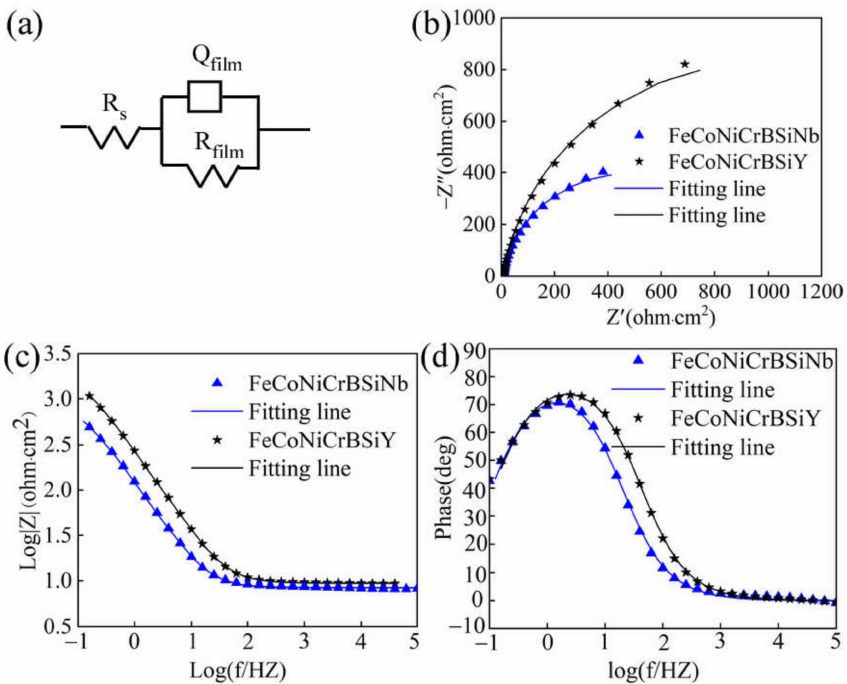
Figure 8. ( a ) Equivalent circuit used to fit EIS data; ( b ) Nyquist plot and ( c , d ) Bode plot of FeCoNi- CrBSiNb and FeCoNiCrBSiY coatings under OCP condition in 3.5wt% NaCl